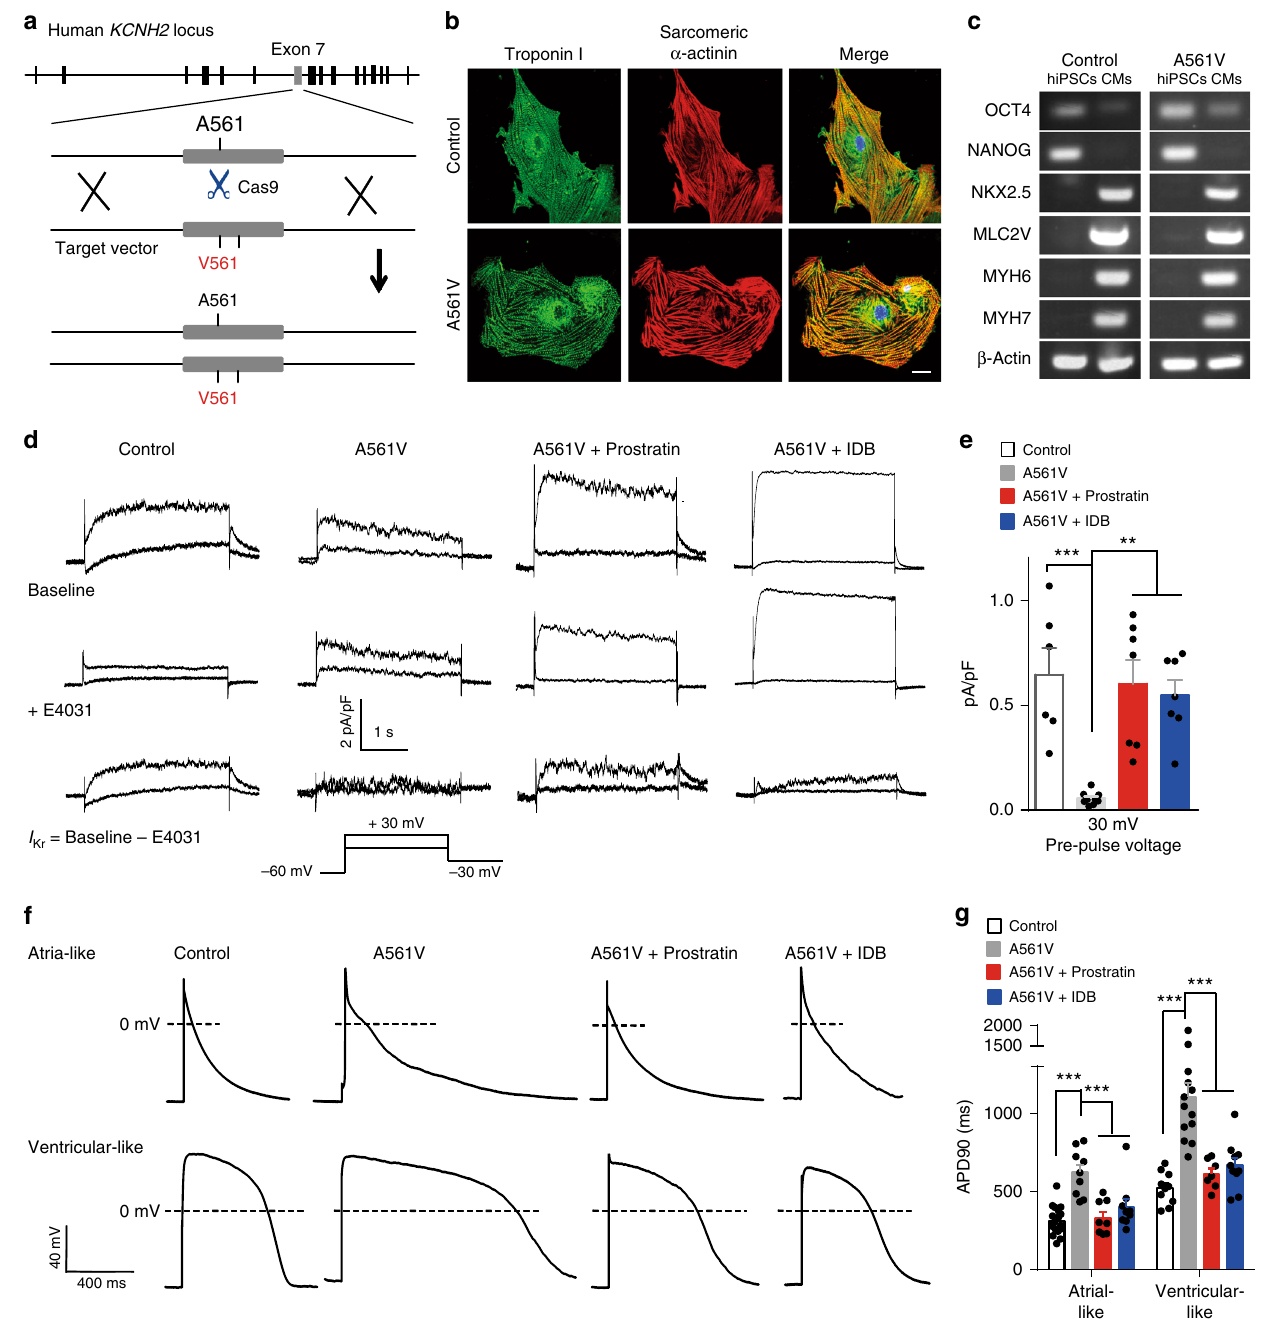
Fig. 6 Prostratin or IDB corrects electrophysiological abnormality of hiPSC A561V -CMs. a Schematic illumination of CRISPR/Cas9-mediated genome editing in KCNH2 (encoding the hERG channel) locus. b Immunostaining for sarcomeric α -actinin and Troponin I in control hiPSC-CMs and hiPSC A561V -CMs. Scale bar: 20 μ m. c RT-PCR analysis of the cardiac-speci fi c transcription factors ( NKX2.5 ) and structural genes ( MLC2V , MYH6 , and MYH7 ) in control hiPSC-CM and hiPSC A561V -CMs. d Representative I Kr currents. e Tail current densities of I Kr . n = 6, 9, 7, and 7 cells for control hiPSC-CMs, hiPSC A561V -CMs, Prostratin- treated hiPSC A561V -CMs, and IDB treated hiPSC A561V -CMs, respectively. f Representative action potentials. g APD90 of action potentials. n = 15, 9, 8,